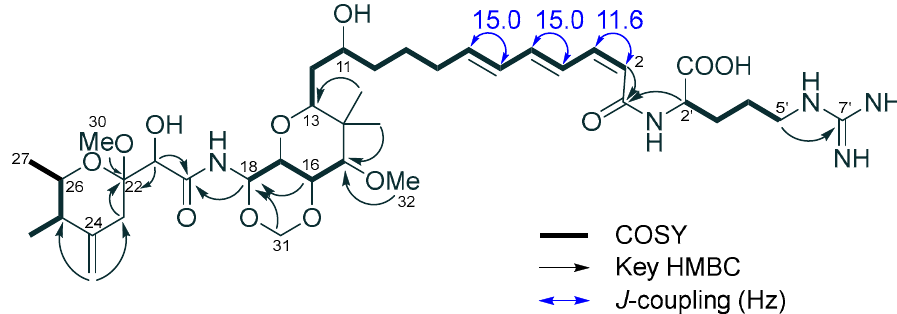
Figure 1. COSY, key HMBC cross-peaks and coupling constants of 2 Z -onnamide A ( 1 ). The molecular formula of 6 Z -onnamide A ( 2 , C 39 H 63 N 5 O 12 ) was also determined to be the same as that of 3 by the positive-mode HRESIMS ( m/z 794.4530 [M+H] + , calcd for C 39 H 64 N 5 O 12 794.4546, Δ− 2.0 ppm). The 1 H NMR spectrum of 2 measured in CD 3 OD was